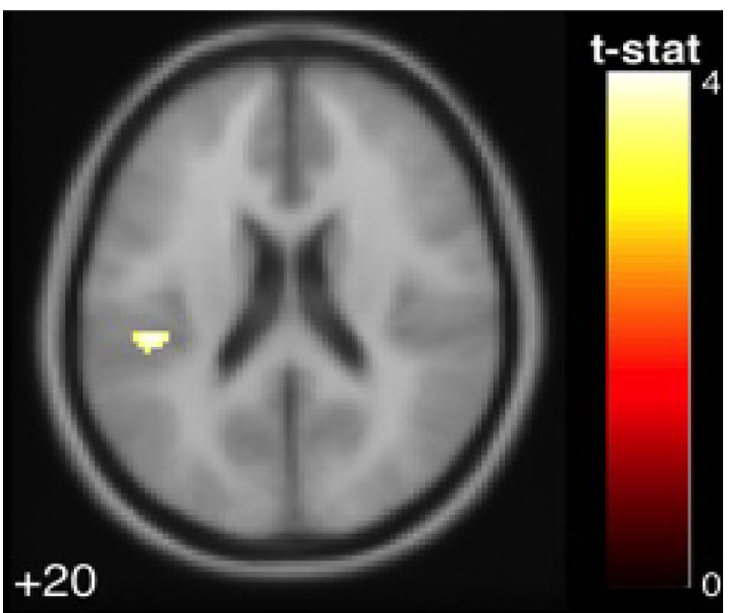
Fig 4. The parietal operculum cortex exhibited a negative association with age in the pooled young and older adults group. The colored voxels show brain regions in which the BOLD signal was significantly increased from rest to stimulation in a fashion that was correlated with subject age. The shade of the color in each brain map corresponds to the t-value in the legend bar.